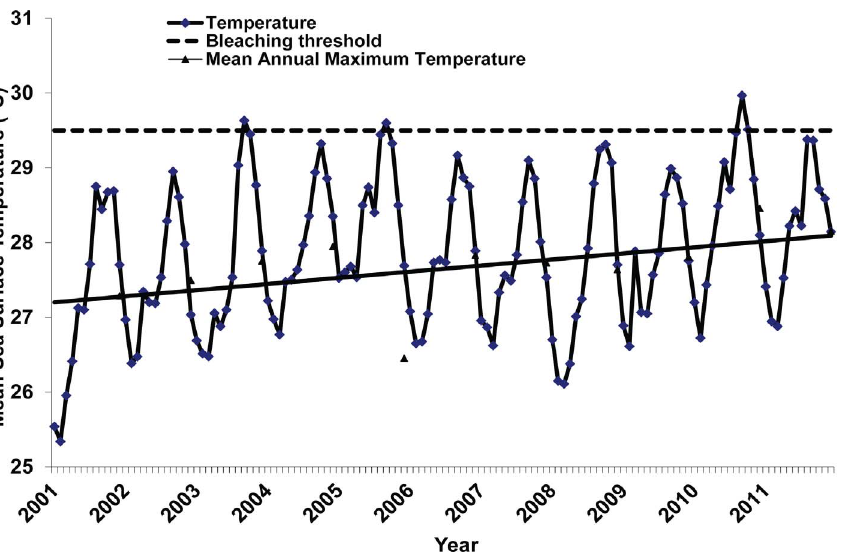
Figure 2. Averaged monthly sea surface temperatures (SST) for Tobago derived from the 50 km night time NOAA Coral Reef Watch Product.